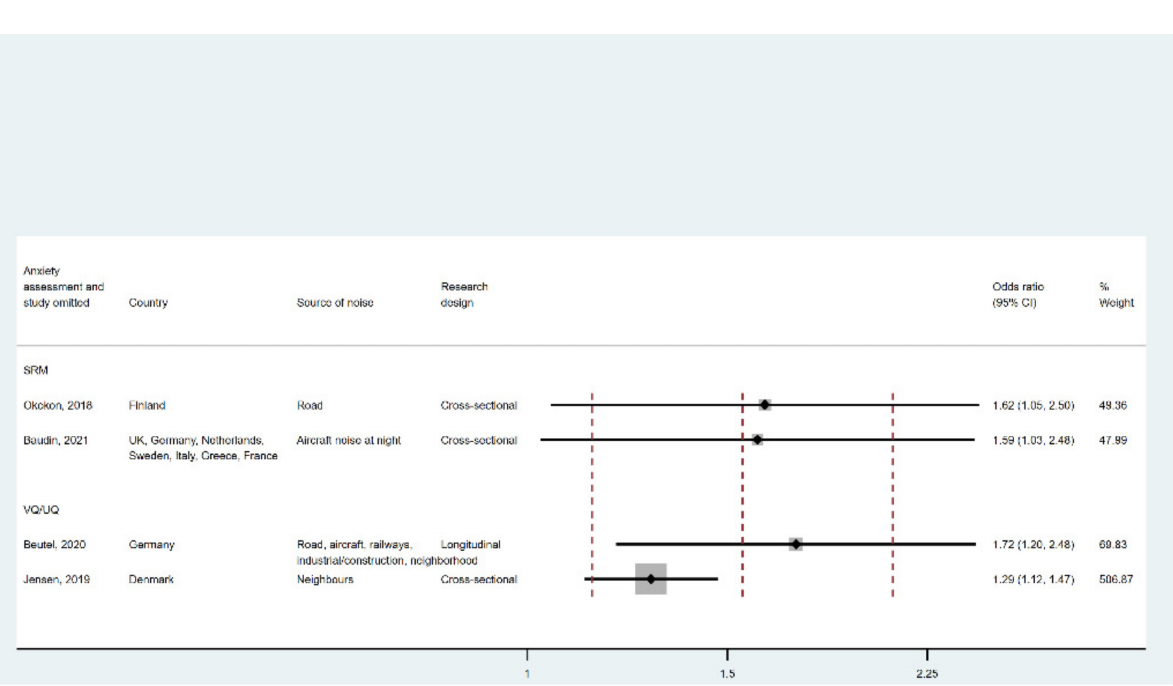
Figure A4. Leave-one-out analysis for identifying outliers in anxiety studies. Note: weights are from random-effects